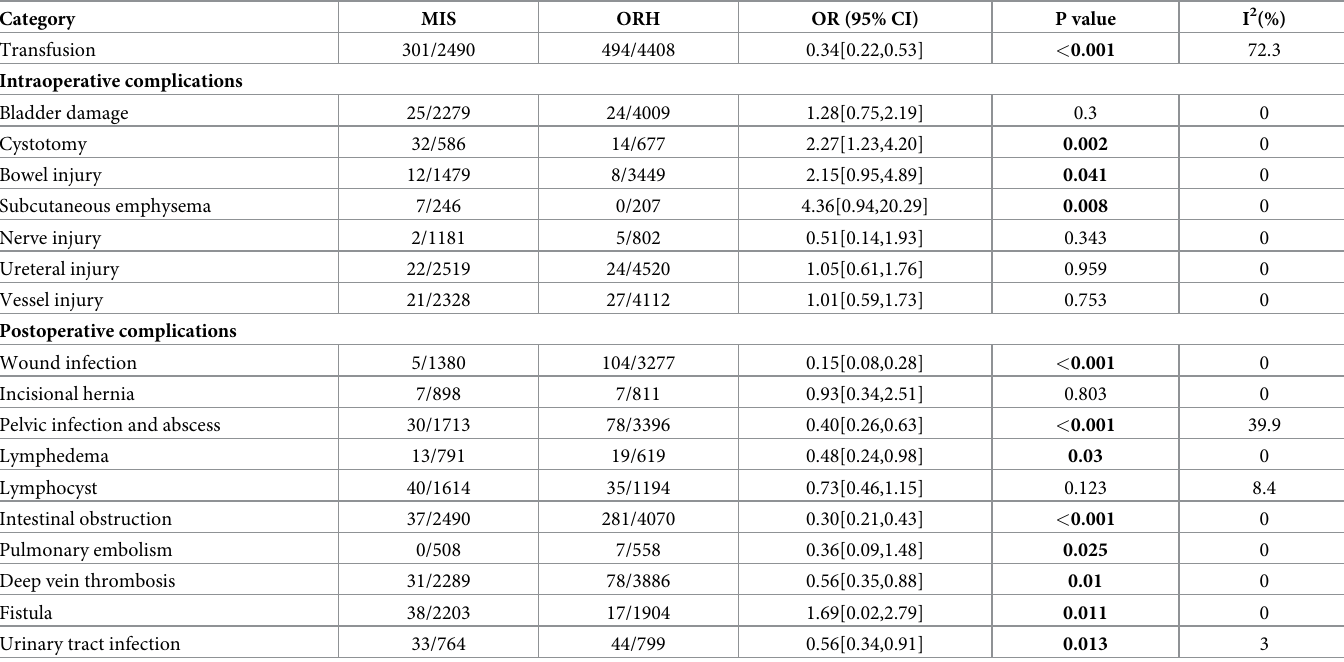
Table 2. Meta-analysis estimates of individual complications between MIS and ORH.